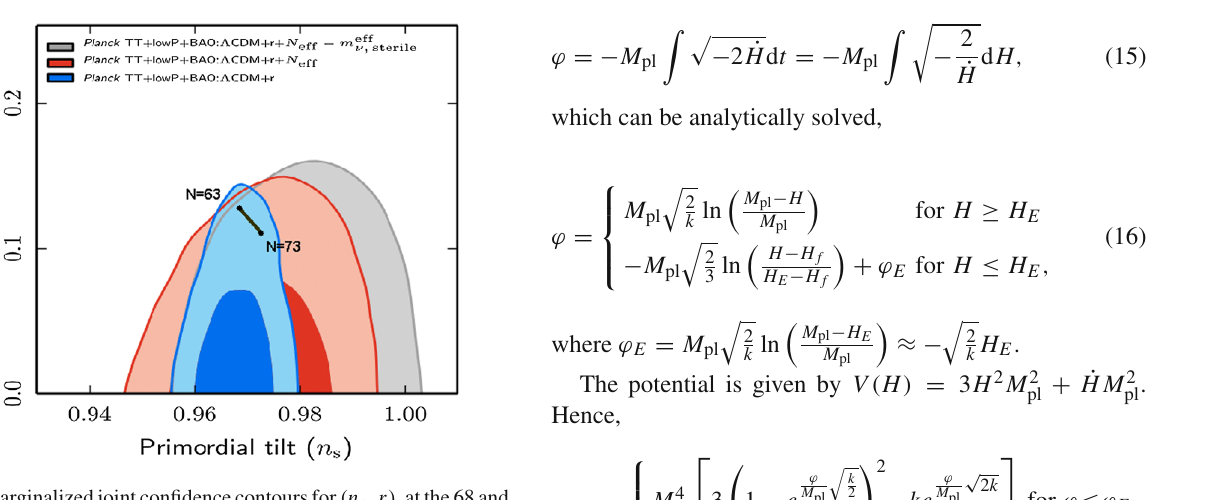
Fig. 1 Marginalizedjointconfidencecontoursfor ( n s , r ) ,atthe68and 95% CL, without the presence of running of the spectral indices. We have drawn the curve from N = 63 to 73 e-folds. (Figure courtesy of the Planck2015